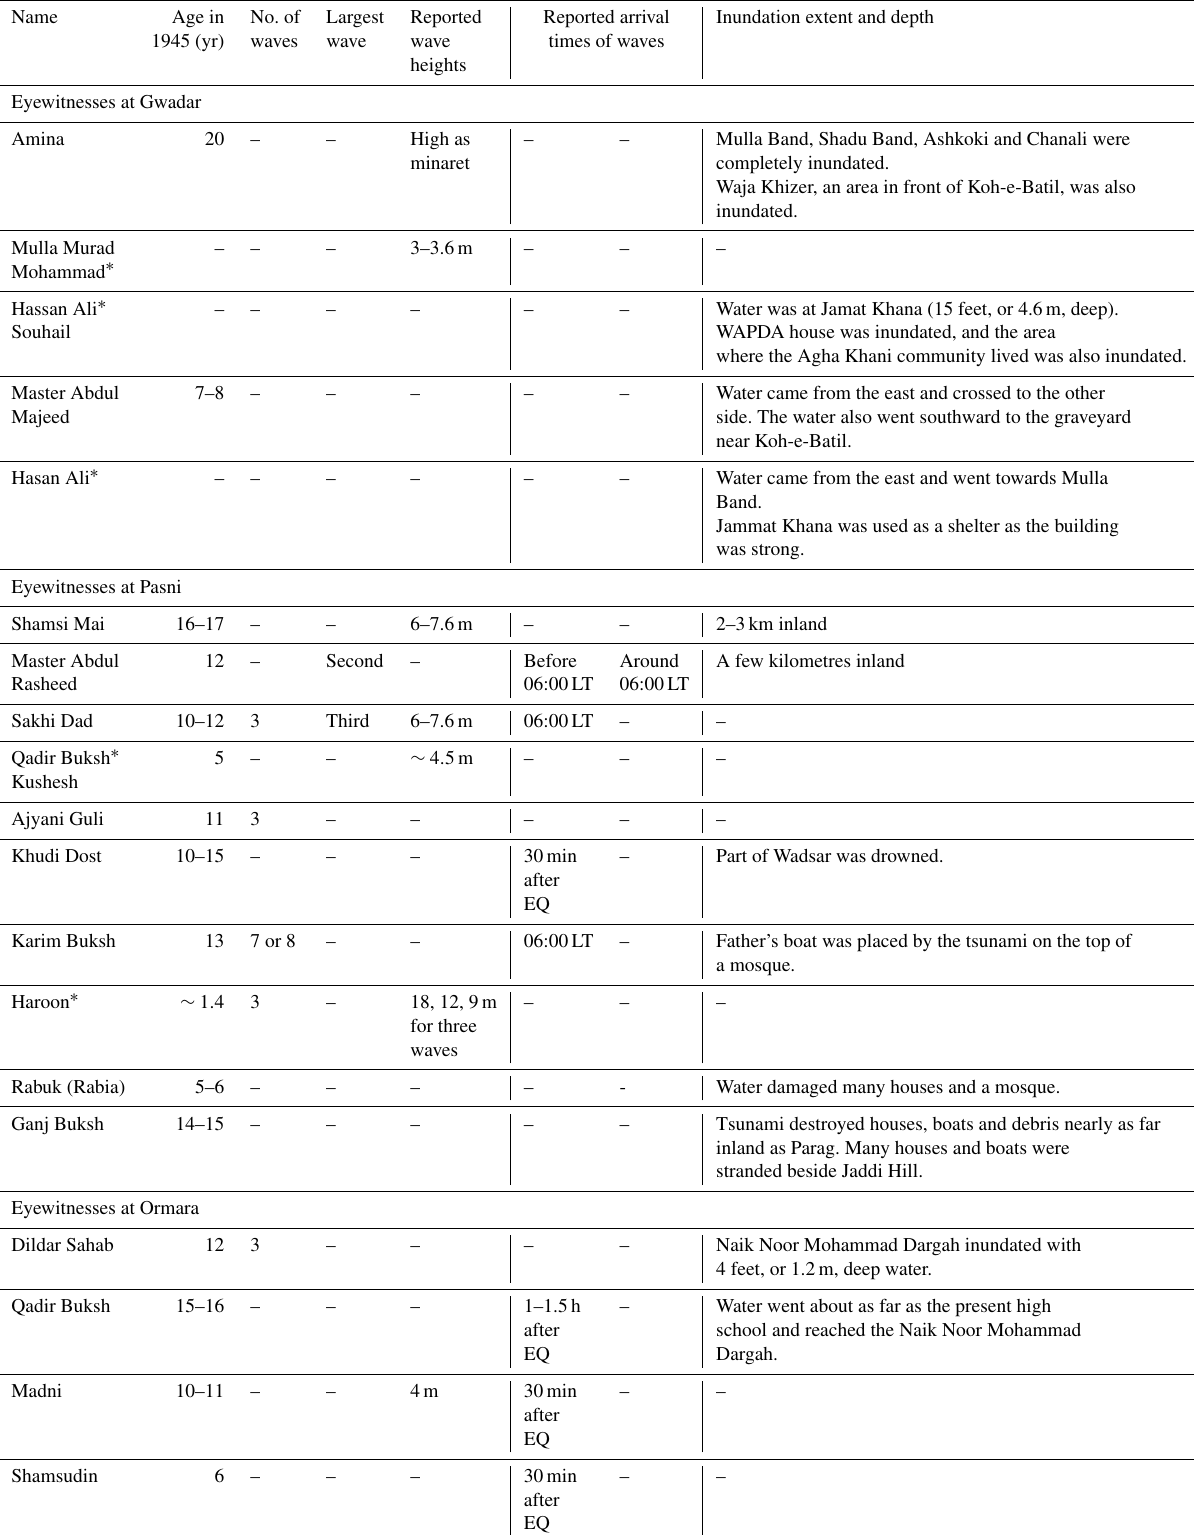
Table 1. Summary of eyewitness accounts. Here EQ stands for earthquake. Wave heights are not from a datum but are personal interpretations of the